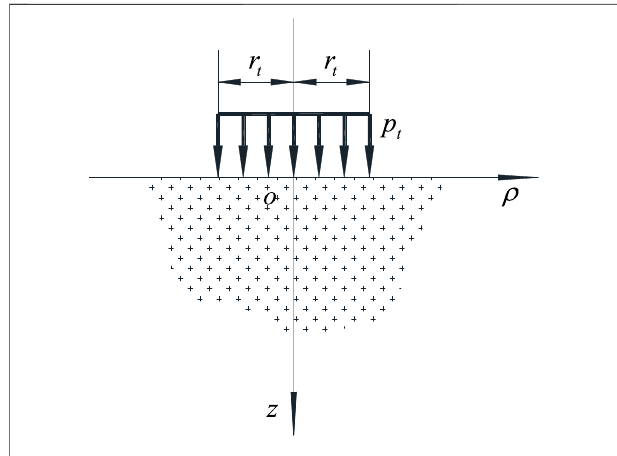
FIGURE 3 | Force of the bearing plate on the rock